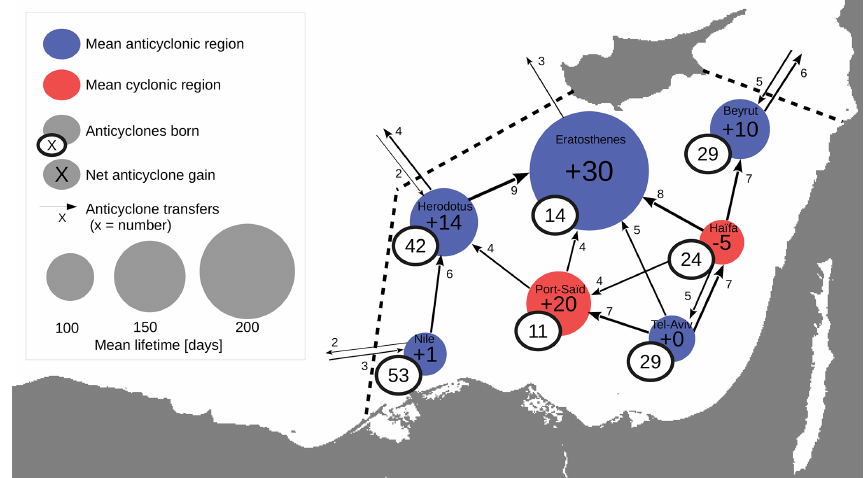
Figure 7. Scheme summarizing inter-region anticyclone transfers within the Eratosthenes anticyclone attractor (EAA) attraction basin (dashed line). Transfers encompass order 0–1–2 anticyclones. Within this basin, only transfers higher than or equal to 4 are represented by arrows (for legibility). All transfers across the basin border are shown. The arrow thickness is proportional to eddy transfers. Red circles represent CY regions, and blue circles represent AC regions; radii are proportional to the anticyclone mean lifetime in the region. More details are given in Table